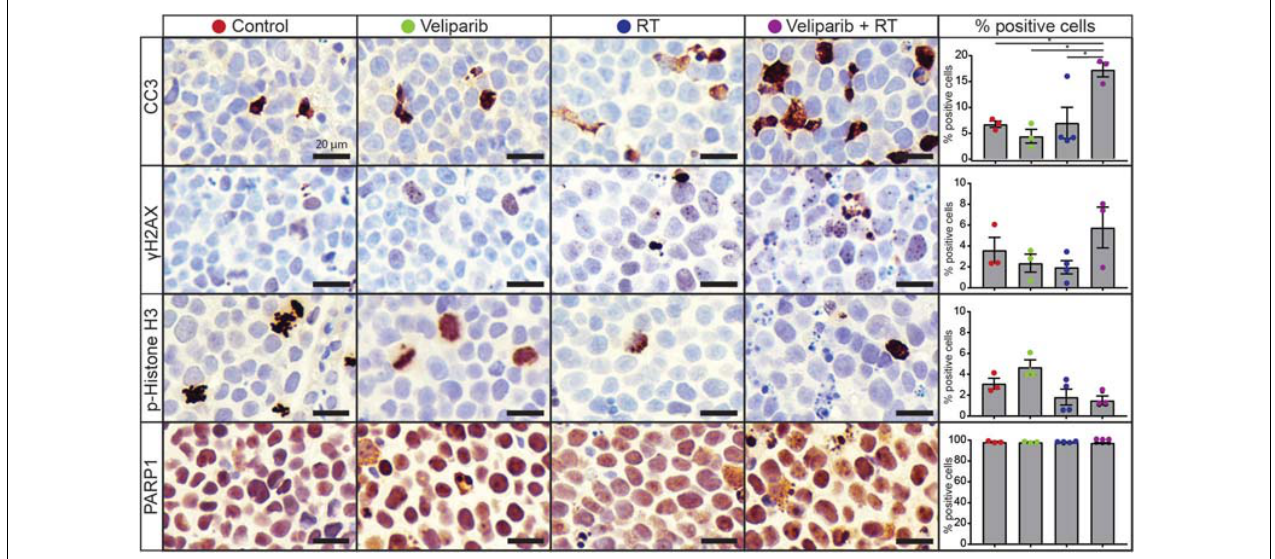
FIGURE 3 | Veliparib in combination with radiotherapy increases apoptosis in an orthotopic xenograft model of medulloblastoma. Representative images are shown of immunohistochemistry for cleaved caspase 3 (CC3), γ H2AX, phospho(p)-histone H3, and PARP1 from D425GiL xenografts in mice treated with vehicle, veliparib, radiotherapy (RT) or the combination of both veliparib and RT. The percentage of positively stained medulloblastoma cells for each antibody were quantified from three independent fields of view per tumor from n = 3 or 4 mice per treatment group. Error bars represent SEM. Scale bar represents 20 µ m. * p <